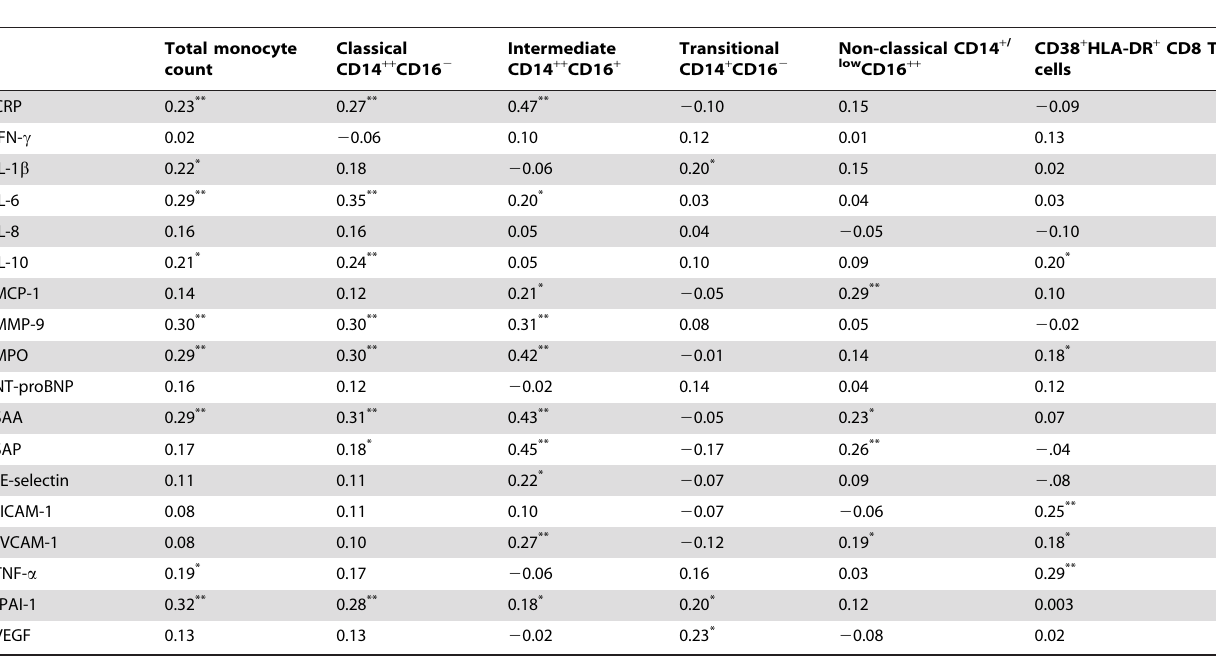
Table 4. Correlation table of absolute counts of total monocytes, monocyte subsets and CD38 + HLA-DR + CD8 T cells with various plasma